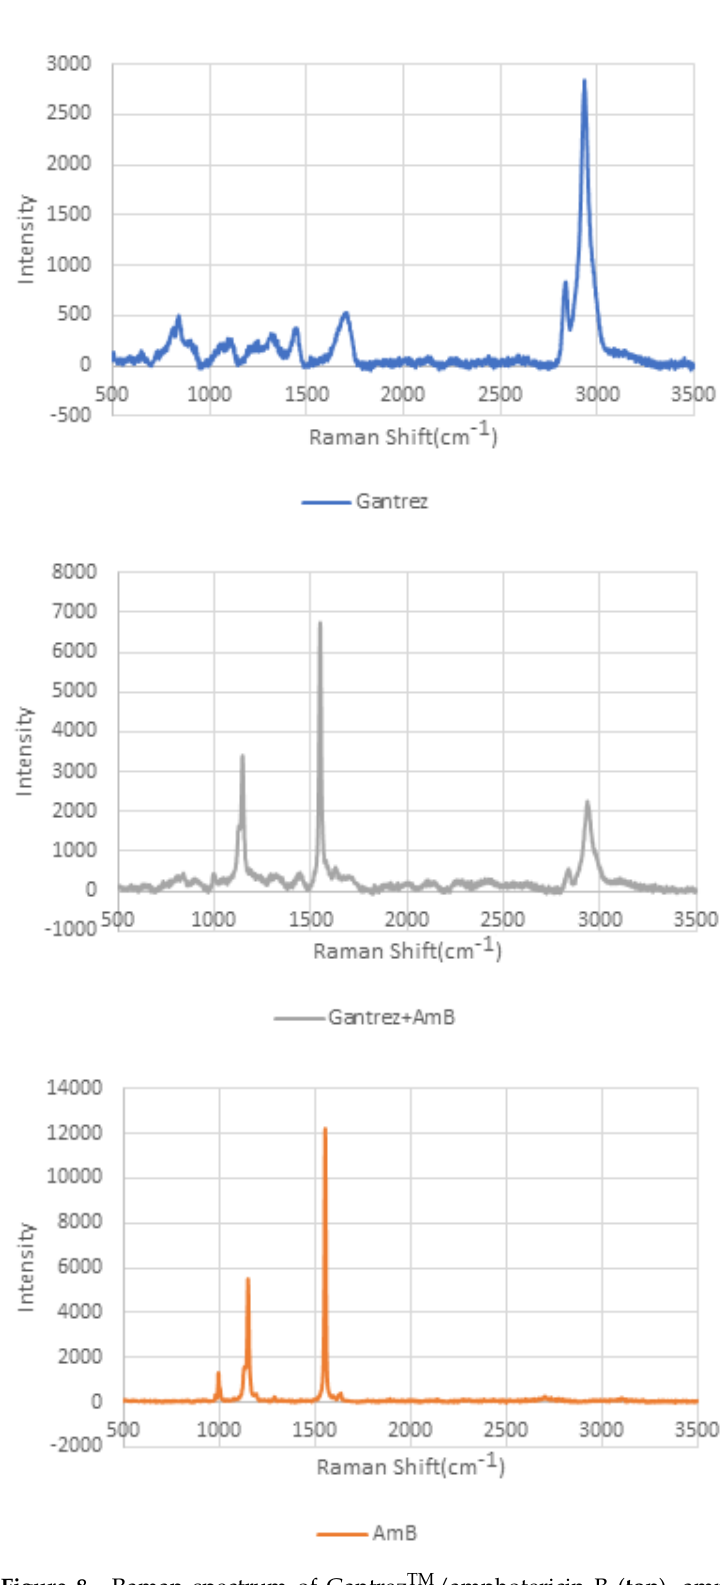
Figure 8. Raman spectrum of Gantrez TM /amphotericin B ( top ), amphotericin B ( center ), and Gan- Gantrez TM ( bottom trez TM ( bottom ).